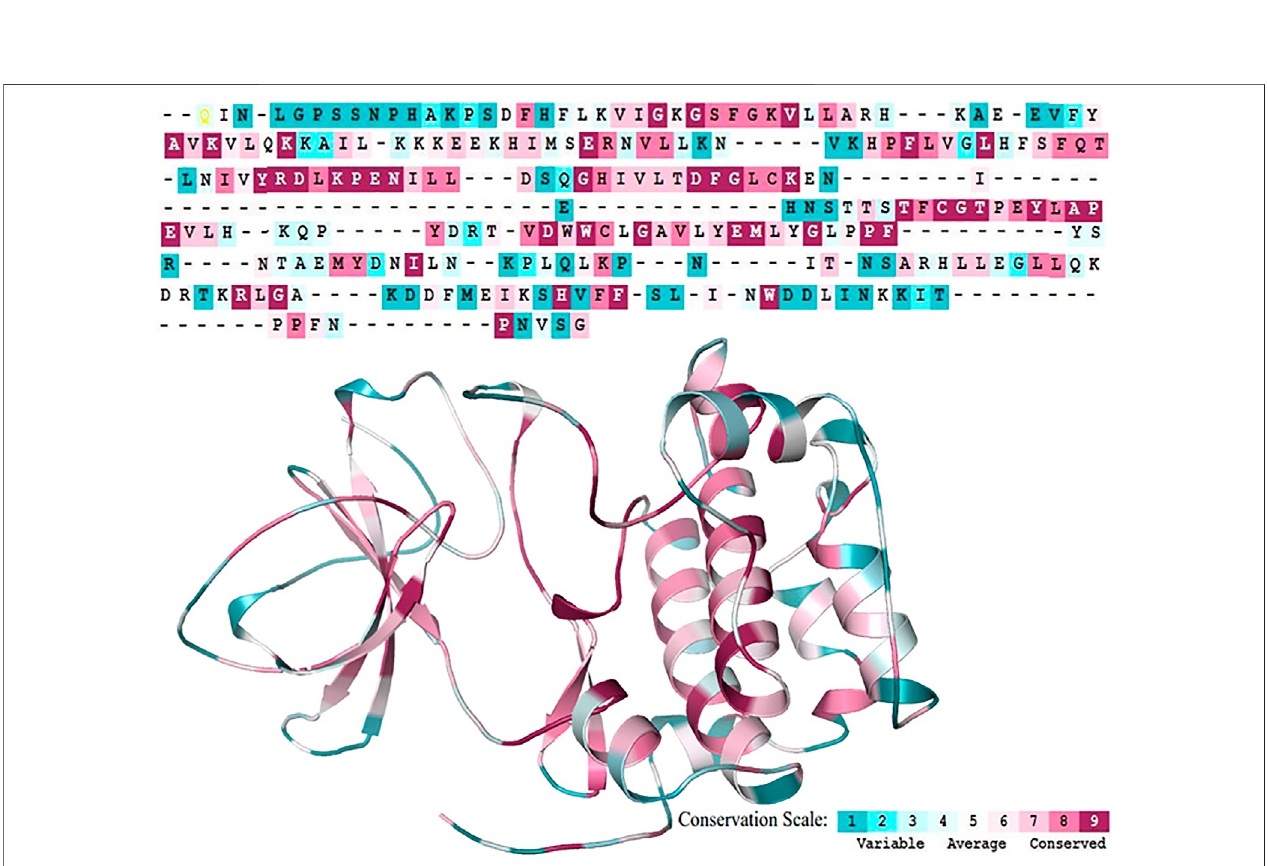
FIGURE 5 | Sequence Conservation analysis of the SGK1 protein using ConSurf web server.